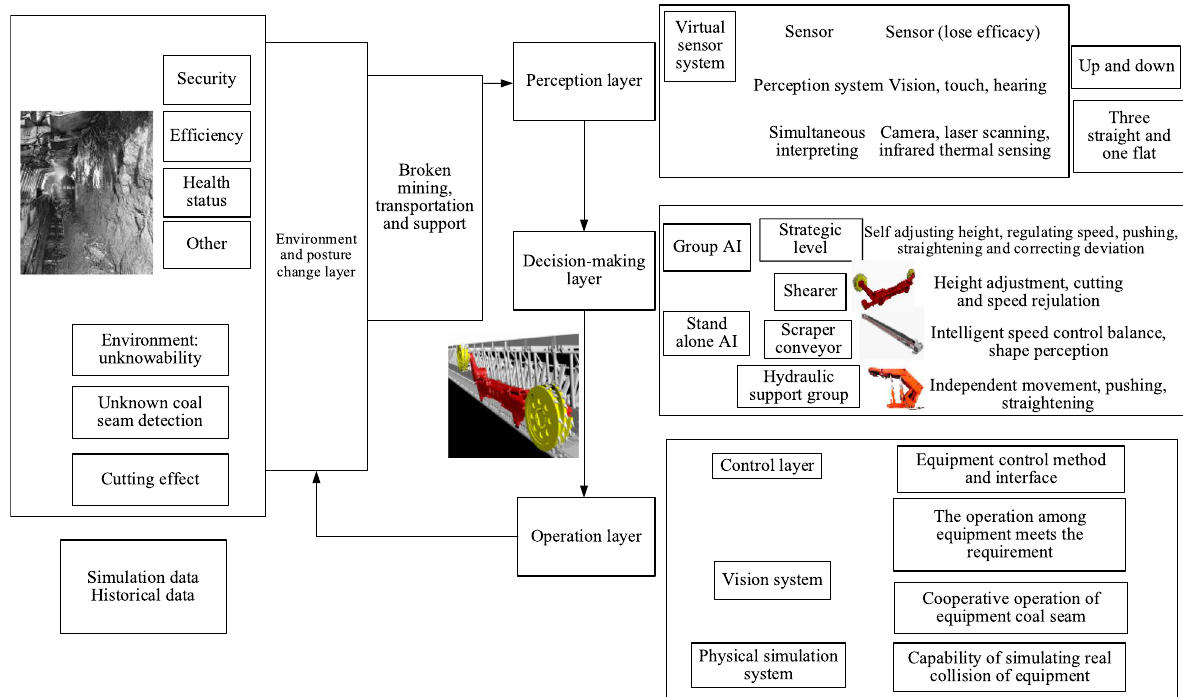
Fig. 9 General framework for the AI operations of virtual mining